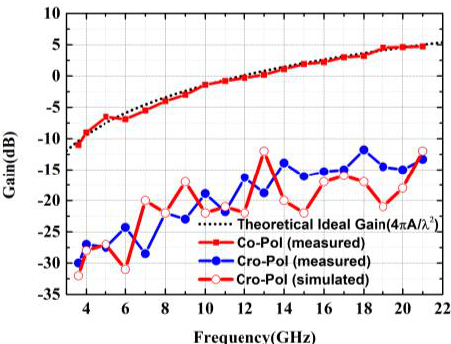
Figure 8. Measured broadside active element co-polarized and cross-polarized gain of central ports (9, 8) compared with theoretical and simulated results.